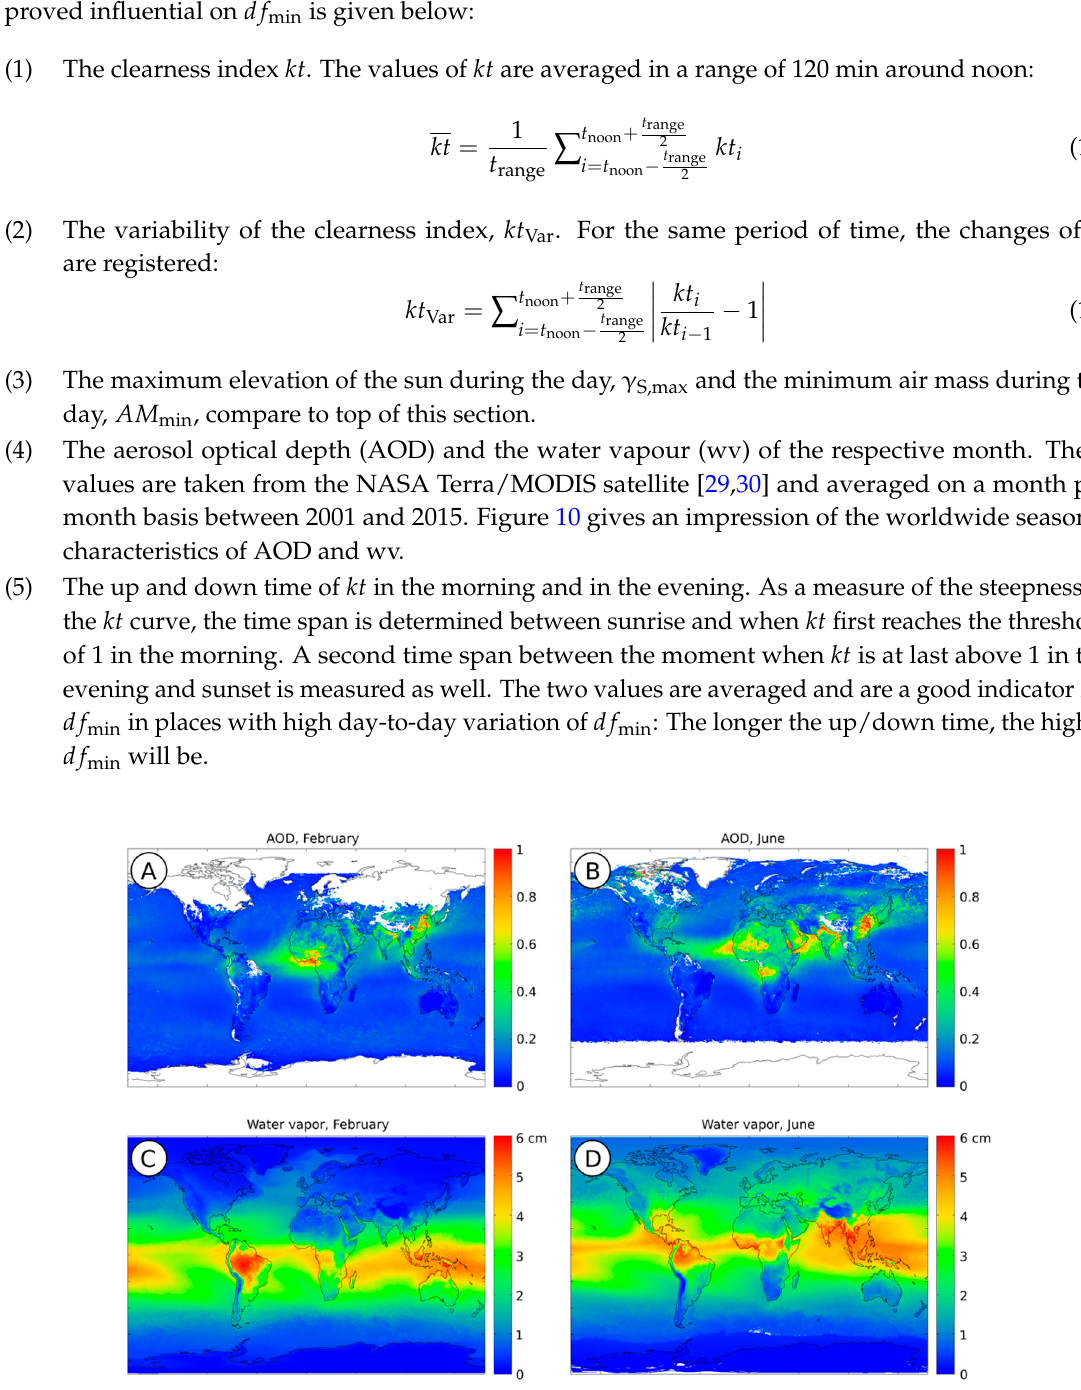
Figure 10. Monthly means of aerosol optical depth (AOD) (plots A and B ) and water vapour ( C , D ) for February ( A , C ) and June ( B , D ), from 2001 to 2015. Data taken from NASA Terra/MODIS satellite [29,30].